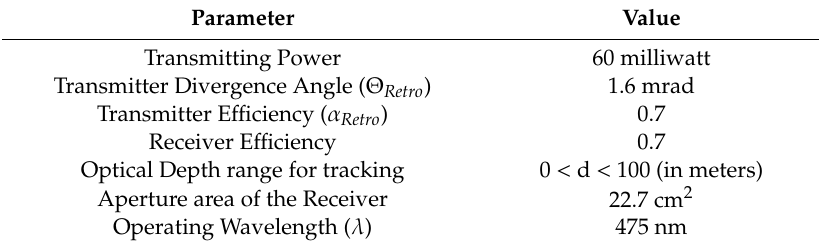
Figure 9. Feature of hybridized model of optical and electromagnetic underwater tracking. Table 7. Parameters used for simulating power received for di ff erent